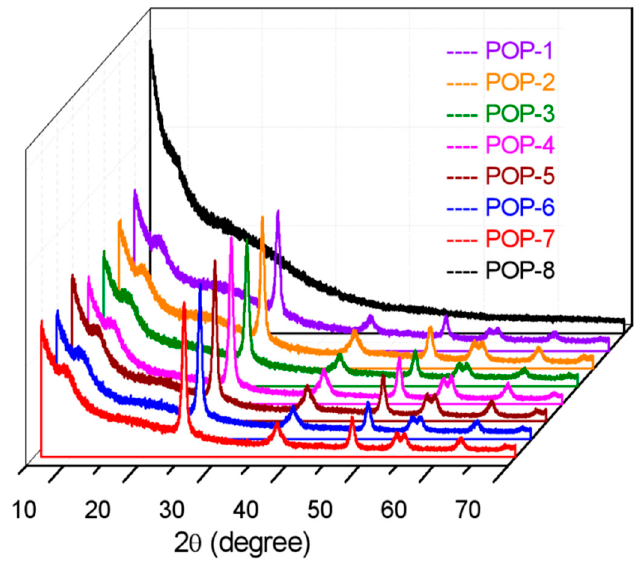
Figure 5. Wide angle X-ray diffraction (XRD) spectra of the prepared TiO 2 /POP particles.